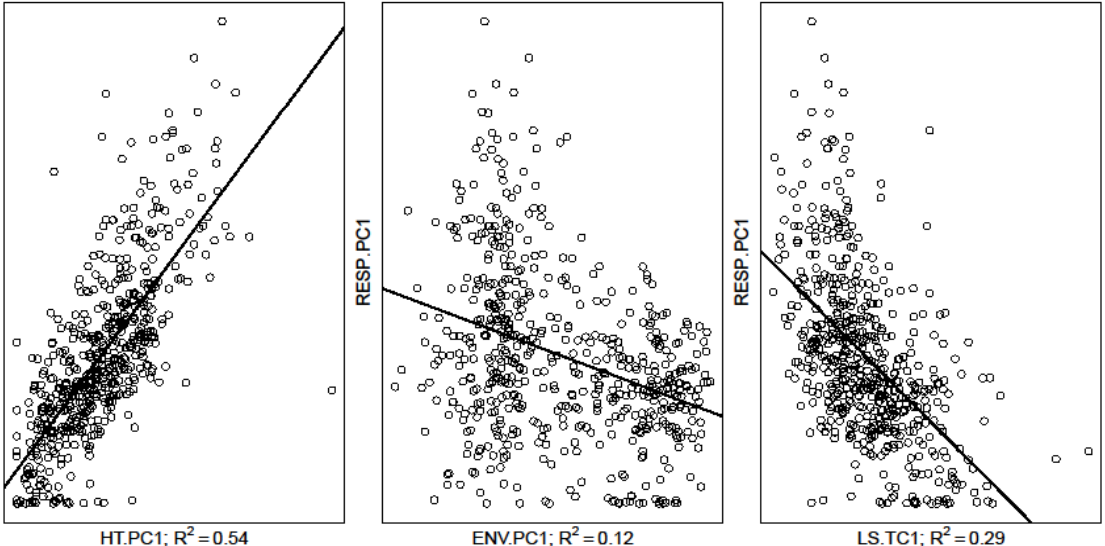
Figure 5. Scatterplots and coefficients of determination (R2) of the response first principal component (RESP.PC1) vs. first principle components for Landsat (LS), DAP Height metrics (HT), and environmental gradients (ENV). The black line is an OLS fit between the RESP.PC1 and respective auxilary variables on the x axes.